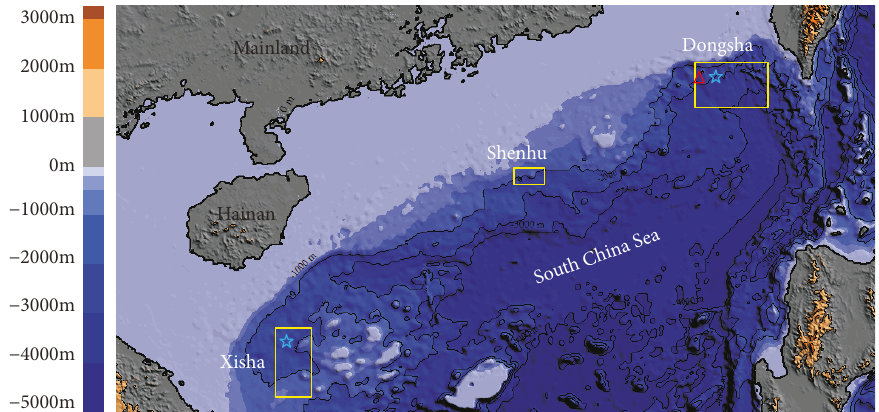
Figure 1: The bathematric map of the northern South China Sea. Rectangle boxes denote study areas. Note that Xisha herein includes the Qiongdongnan basin and Xisha Uplift, and Dongsha comprises a broad area of the eastern Zhujiangkou basin and SW Taiwan basin. The blue stars denote active seepage sites. The red triangle represents the Jiulong methane reef covering an area of ~ 400km 2